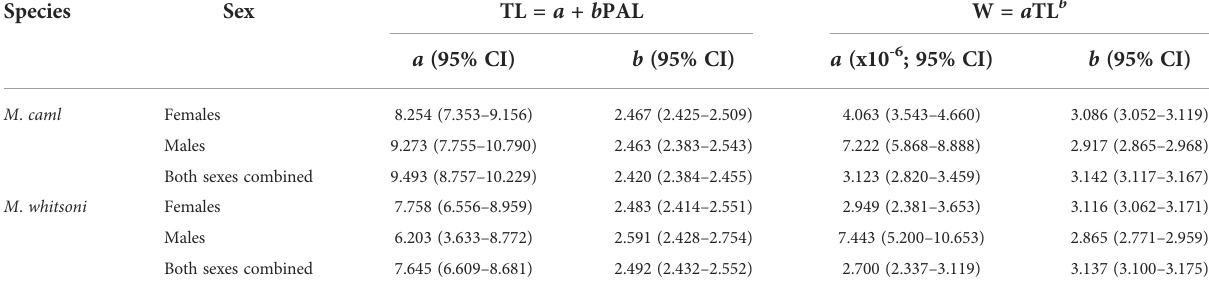
TABLE 2 Summary of coef fi cients (and 95% con fi dence intervals; CI) of the relationship between pre-anal length (PAL, cm) and total length (TL, cm), and TL and weight (W, kg), for Macrourus caml and M . whitsoni in the Ross Sea region. Species